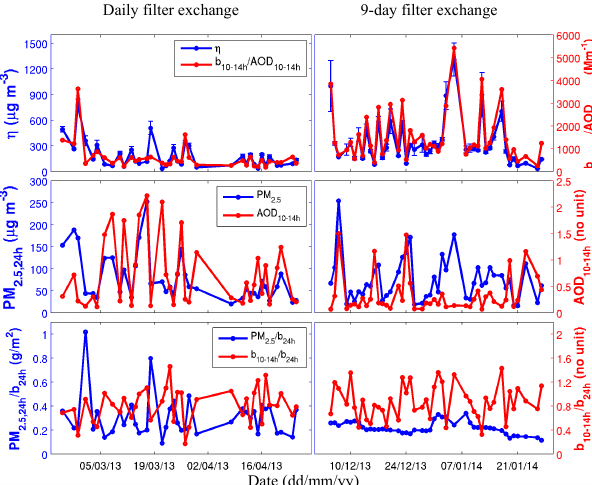
Figure 3. Temporal variation in Beijing, China, of η (calculated as the mean 24h PM 2 . 5 divided by mean ground-measured AOD re- trieved during satellite overpass times) and related variables. Error bars represent 1 σ measurement uncertainty ( σ PM σ AOD = 0 . 02). The left column (February–April 2013) used daily sampled filters, while the right column (December 2013–January 2014) sampled each filter intermittently over